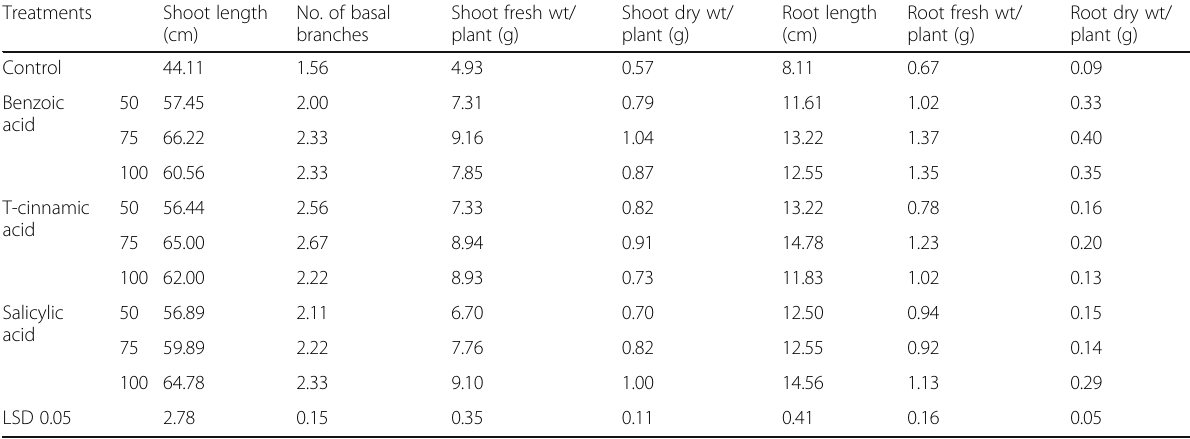
Table 17 Effect of benzoic, t-cinnamic, and salicylic acids levels on growth parameters of flax plants grown under sandy soil conditions (data are means of two successive seasons) Treatments Shoot length (cm)